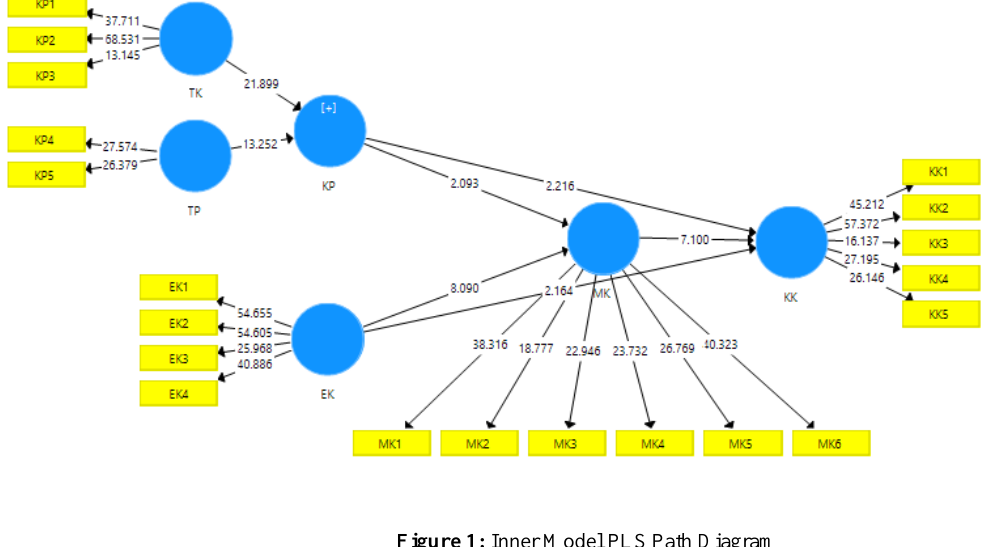
Figure 1: Inner Model PLS Path